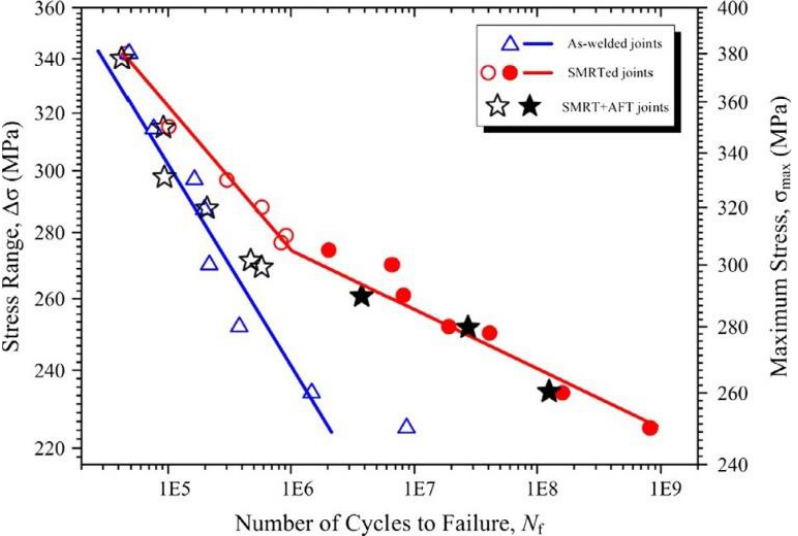
Figure 5. Comparison of fatigue test data (axial load, R = 0.1) of FSW 7075-T651 aluminum specimens with as-welded, SMRTed, and SMRT + AFT conditions. The SMRT + AFT condition indicates that specimens had an additional microgroove added after processing with SMRT to simulate the surface condition of as-welded specimens. The open symbols represent the surface crack failures and the solid symbols represent the interior crack failures. Reprinted with permission from Ref. [1]. Copyright 2019 Elsevier.